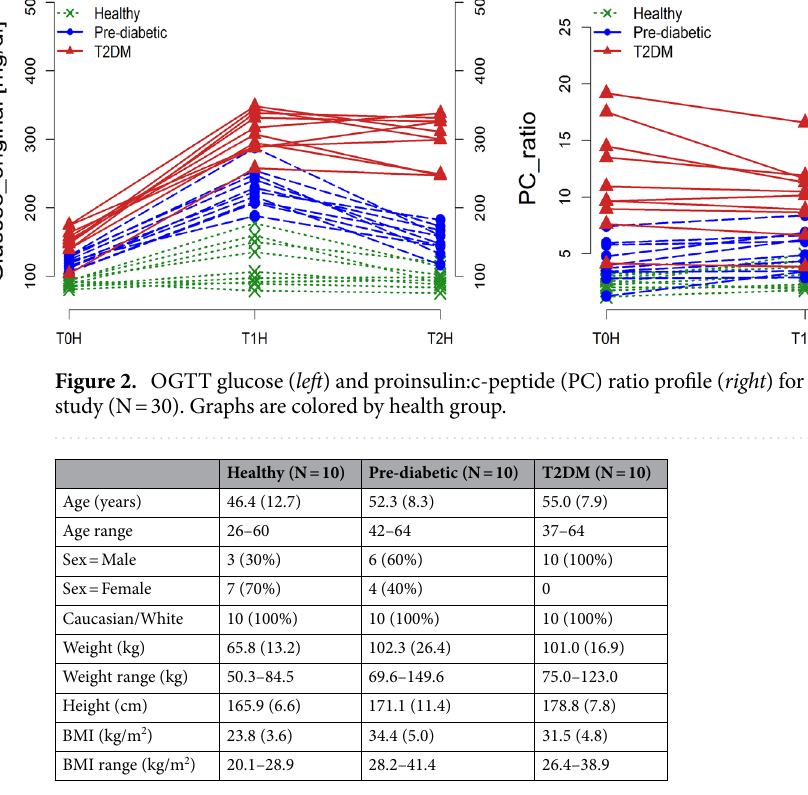
Table 2. Demographics and baseline characteristics of the study